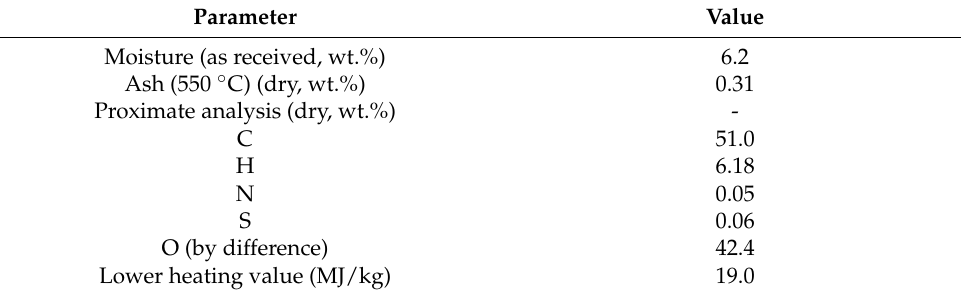
Table 1. Properties of wood pellets used as fuel in combustion experiments.